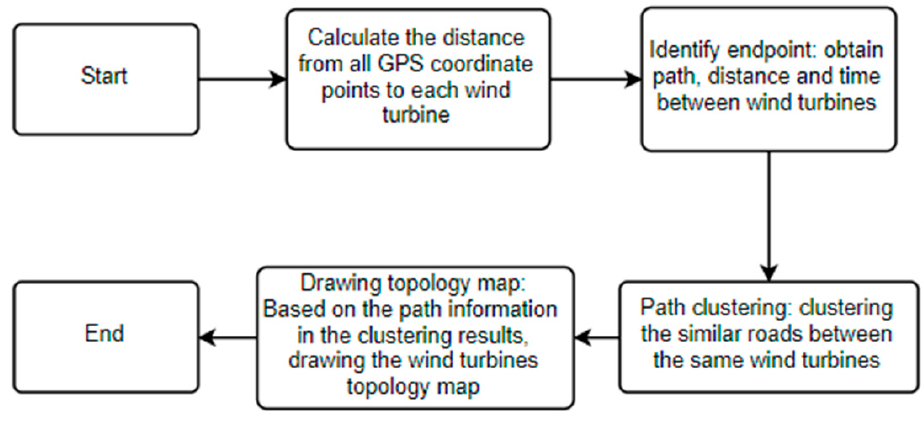
Figure 7. GA algorithm logic [10].